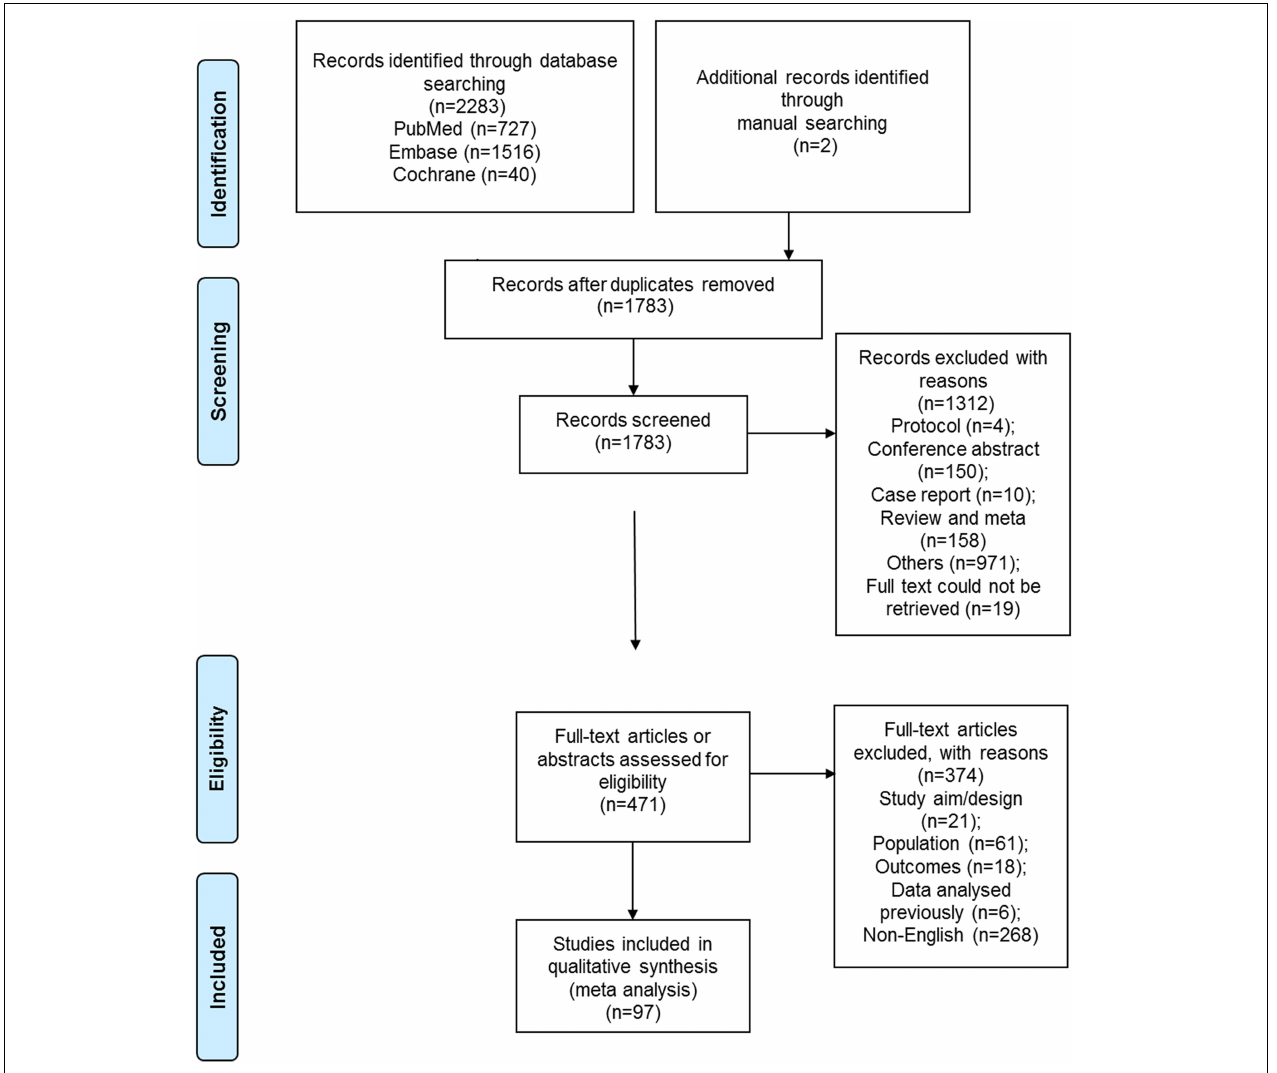
FIGURE 1 | Flowchart of the search